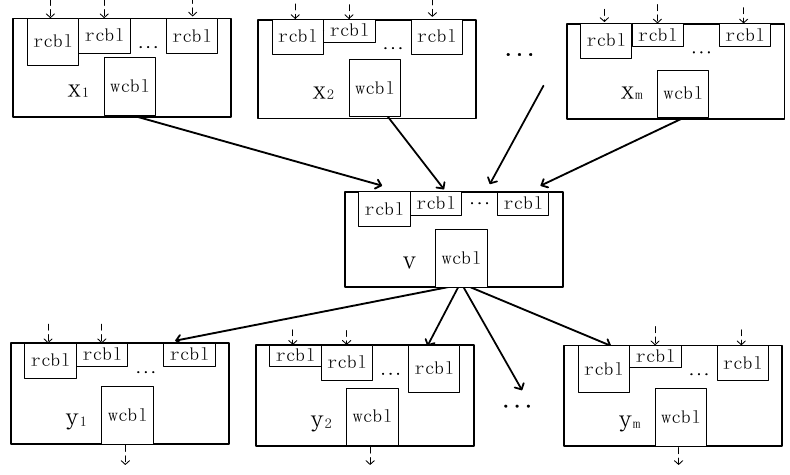
Figure 3. Directed acyclic graph (DAG) considering the queue length of the controllers.